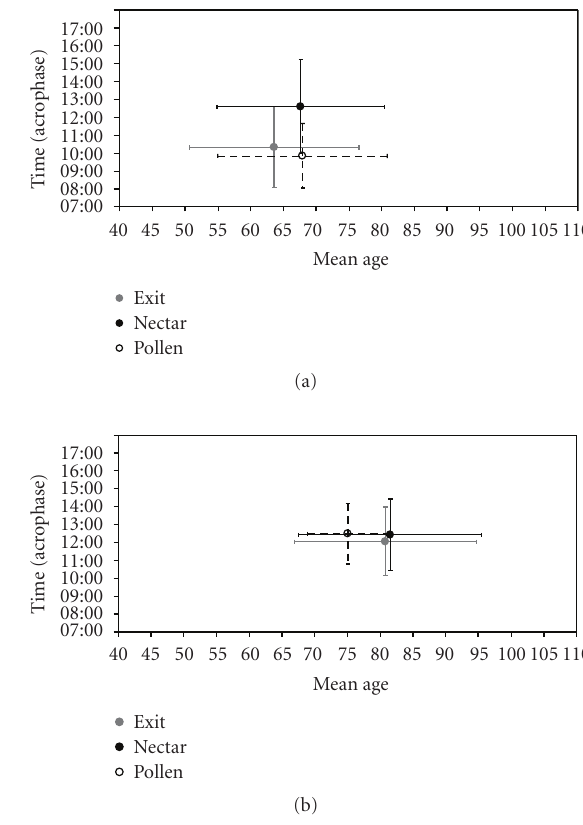
Figure 8: Acrophases with their respectives angular deviations ( y axis) and mean ages with their respectives standard deviations ( x axis) of nectar and pollen foraging and exit of marked bees of colony 1 of Plebeia remota , in the reproductive phase (a) and reproductive diapause (b).